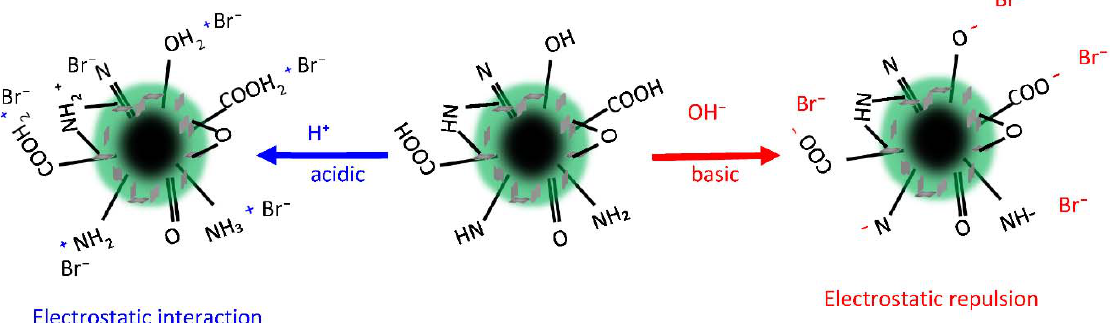
Figure 7. Schematic representation of the Br − adsorption mechanism of PANI/GO@GTW under acidic and basic solution conditions.